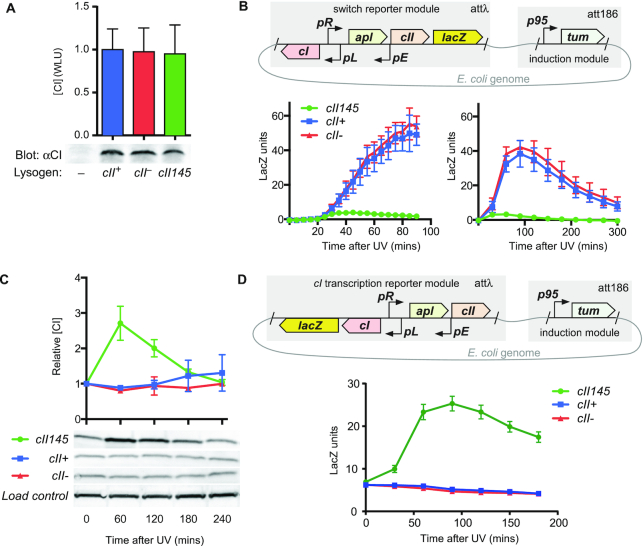
Regulatory effects of CII stabilization. (A) Lysogenic CI concentrations of 186 variants. Relative levels of CI present in non-lysogens and lysogens of 186+.CmR, cII–.CmR and cII145.CmR as detected by Western blot. Bars show mean and standard deviation (n = 4) of quantitation of the CI band (expressed relative to 186+.CmR) for experimental repeats. There was no statistically significant difference between CI levels in lysogens of 186+.CmR and cII–.CmR (P = 0.90; unpaired, two-tailed t-test), nor 186+.CmR and cII145.CmR (P = 0.82; unpaired, two-tailed t-test). (B) Timecourses of pR activity after UV induction. The schematic shows the switch reporter and the 186 tum induction module. The lacZ gene was translationally fused to the 186 fil gene. After UV irradiation (5.2 J/m2) of strains, pR activity was measured by β-galactosidase assay every 5 or 30 min, for 90 or 300 min, respectively. (C) Expression of CI was measured by Western blot in the same irradiated cultures used for β-galactosidase assay in (B). Analysis of CI Western blots shows a significant elevation of CI in the cII145 variant following UV induction, but not in the cII+ or cII– variants. Plots in (B) and (C) show mean and standard deviation (n = 3). (D) As in (B), except the lacZ gene was a translational fusion to the 186 int gene in order to measure leftward transcription. Errors are 95% confidence limits (n = 6–8).